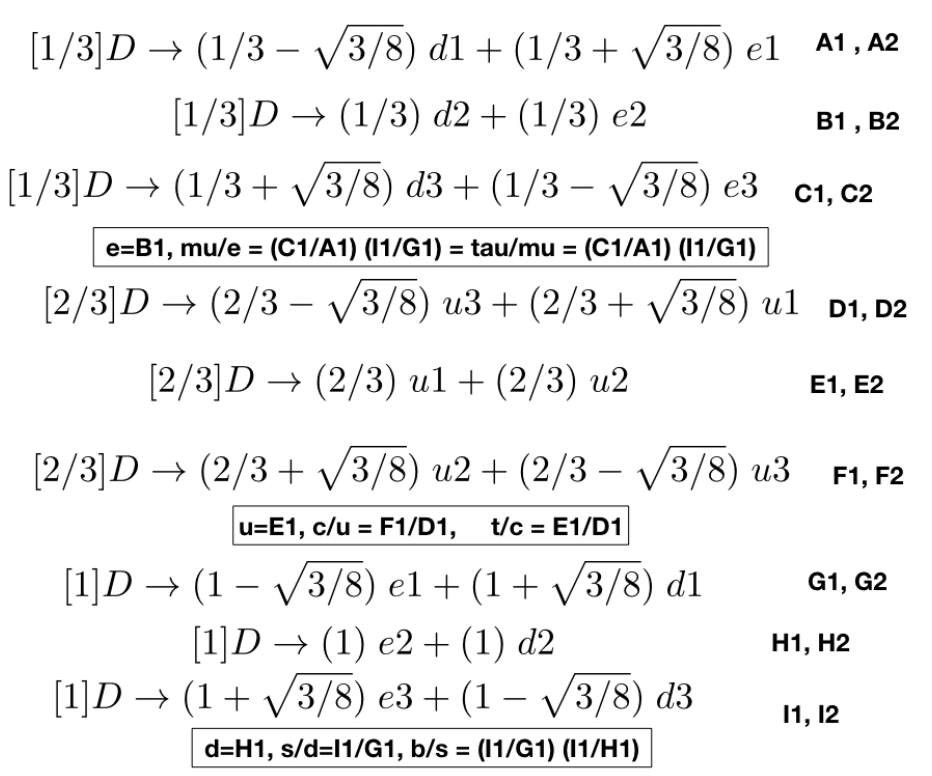
Figure 5. From the Jordan eigenvalues, towards an understanding of the mass ratios. e 1, e 2, e 3 denote the charged lepton family. d 1, d 2, d 3 denote the down quark family. u 1, u 2, u 3 denote the up quark family. D stays for the ‘Dirac neutrino.’ See text for more